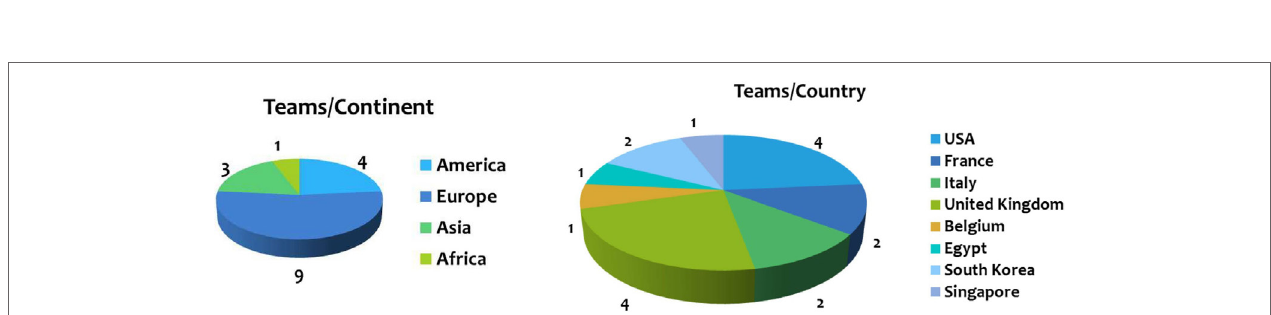
FIGURe 6 | the RsGC raised worldwide interest, with 17 teams participating from 4 different continents which proposed 19 robots . Financial support was provided to selected teams for traveling, accommodation and meals, for a maximum of two members for each selected team.